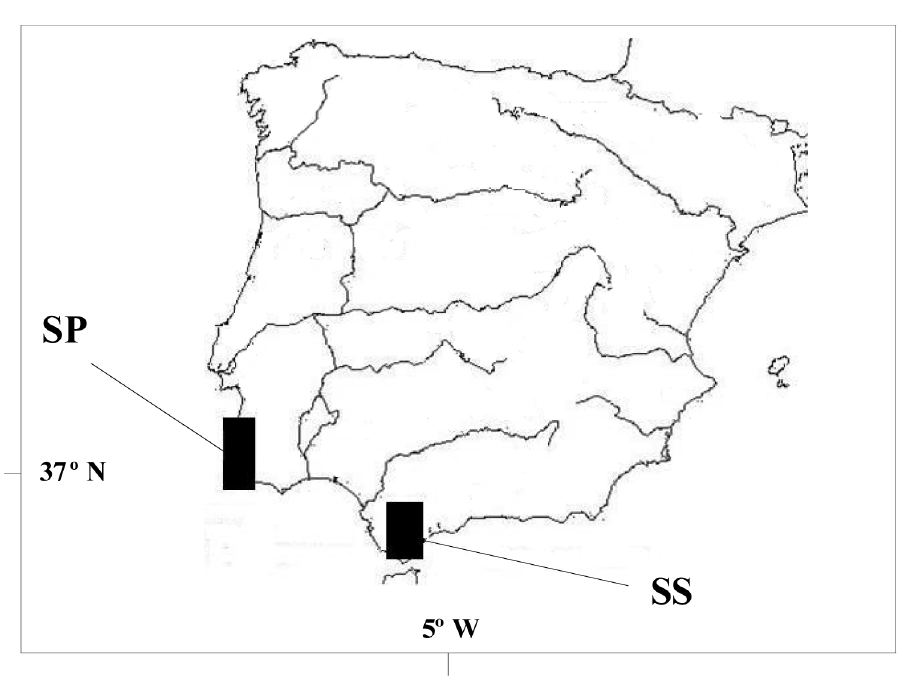
Fig. 1. Location of the study areas in the Iberian Peninsula. SS = Spanish site at Los Alcornocales Natural Park ; SP = Portuguese site at Sudoeste Alentejano e Costa Vicentina Natural Park